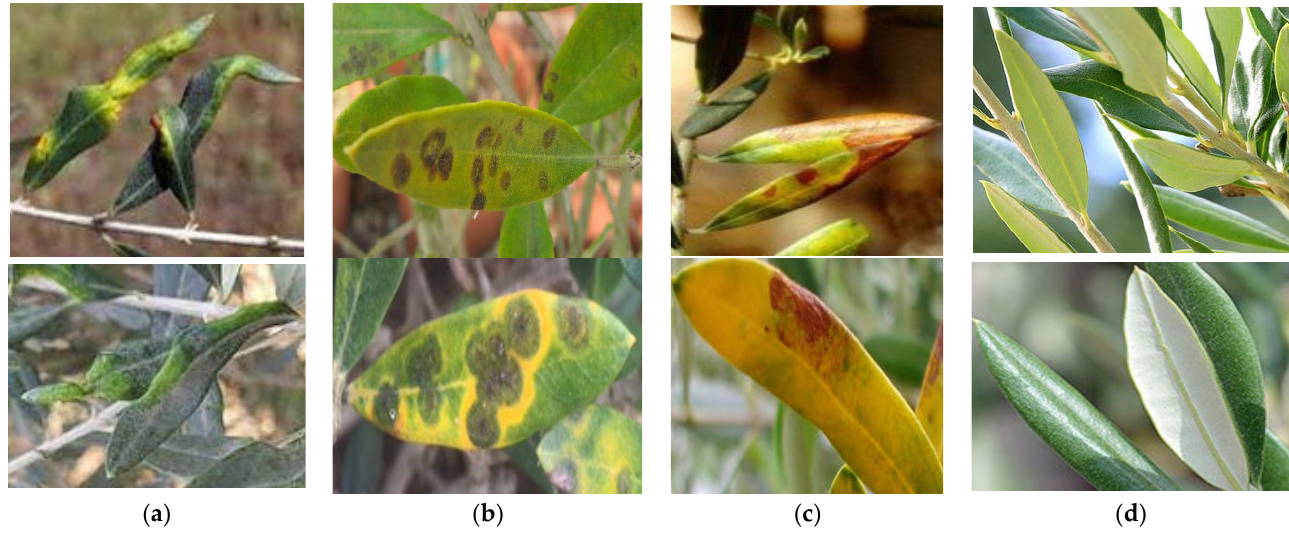
Figure 6. Slices of typical images with four types of olive leaf disease findings: ( a ) Aculus Olearius; ( b ) olive scab; ( c ) peacock spot; ( d ) healthy.